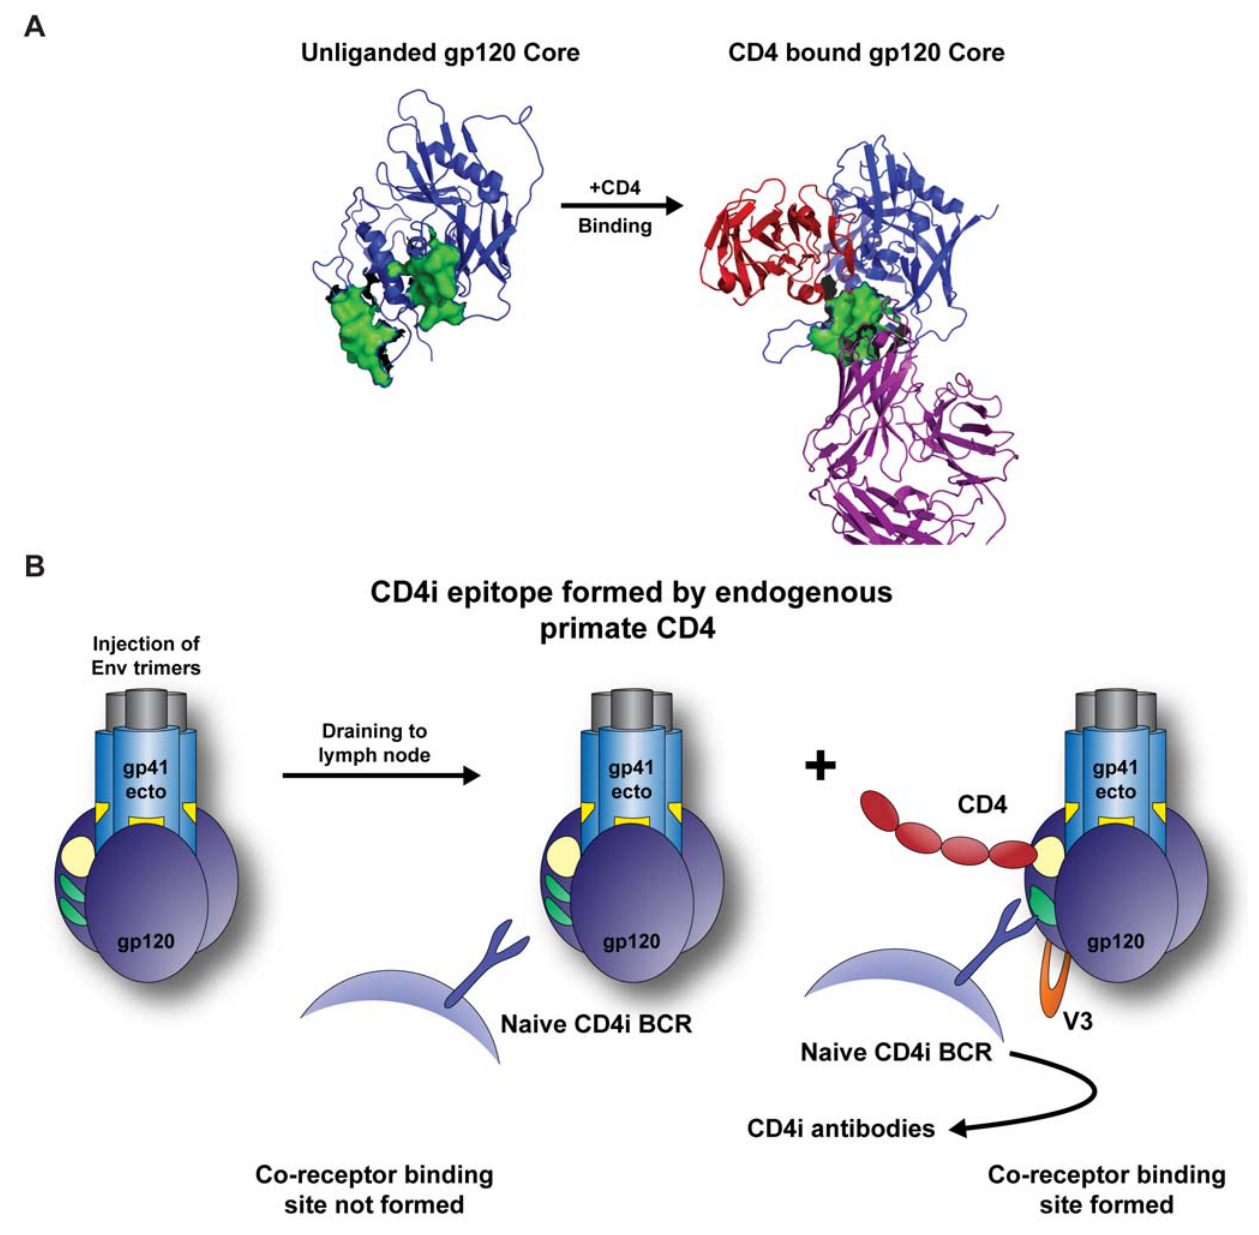
Figure 7. Schematic representations of the pre-CD4 and post-CD4 conformations of Env. (A) Based upon the structures of the unliganded SIV core gp120 [40] and the CD4-bound HIV-1 core [41], the movements of the co-receptor site bridging sheet beta-strands are highlighted in green. Note that 17b binds to the unliganded HIV-1 core with low affinity ( , 1 uM) consistent with the ‘‘split orientation’’ of the bridging sheet revealed by the unliganded SIV core structure. 17b can also recognize full-length gp120 with high affinity [6] and the gp140 trimers as demonstrated in this study (see Figs 2 and 3). These observations suggest that the bridging sheet may not be in exactly the same conformation in the full-length protein context as it is in the original gp120 core protein structures with and without CD4. (B) A model of how the co-receptor region (green) is recognized by the naı¨ve B cell receptor repertoire. In the left and middle panel, the co-receptor binding site is not formed. Following binding to high-affinity primate CD4 (likely on the surface of CD4 + cells), the bridging sheet is formed and locked into a single, CD4-dependent conformation, which then allows elicitation of co-receptor-site-directed, CD4i antibodies (right panel). The somatically mutated and affinity-matured 17b antibody can recognize either conformation, presumably inducing a proper fit of the unliganded bridging sheet